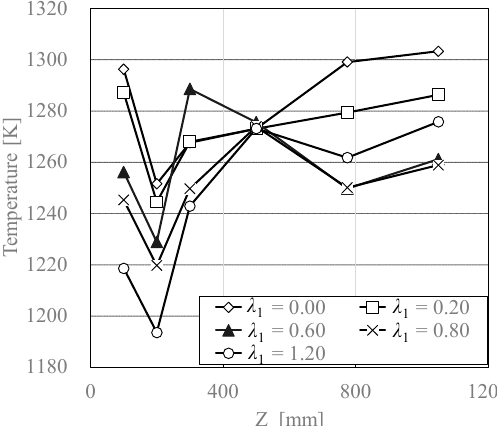
Figure 4. Comparison of temperature distribution for different λ 1 . Input = 11.63 kW, λ total = 1.2, E NH3 = 10% ， L = 100 mm.